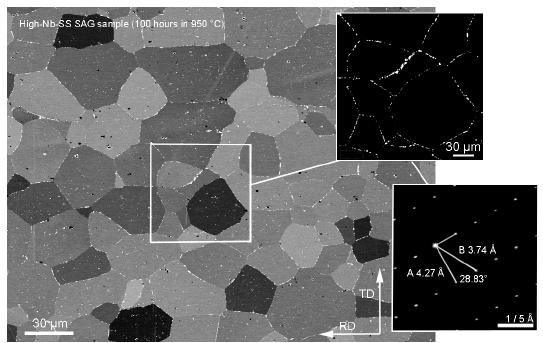
Figure 8. FESEM backscatter image of sag test sample after 100 h in 950 °C. In-set shows η -phase only on grain boundaries (=0.77wt.%) and typical TEM diffraction image of η -phase particle.